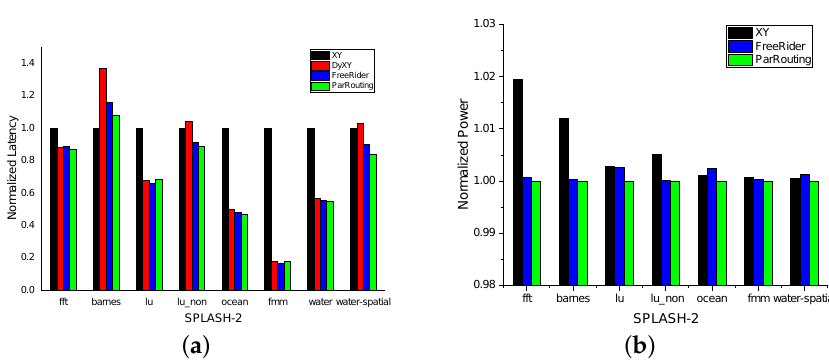
Figure 12. Normalized performance and power consumption for 8 × 8 2D-Mesh network on SPLASH-2. ( a ) Normalized latency. ( b ) Normalized power